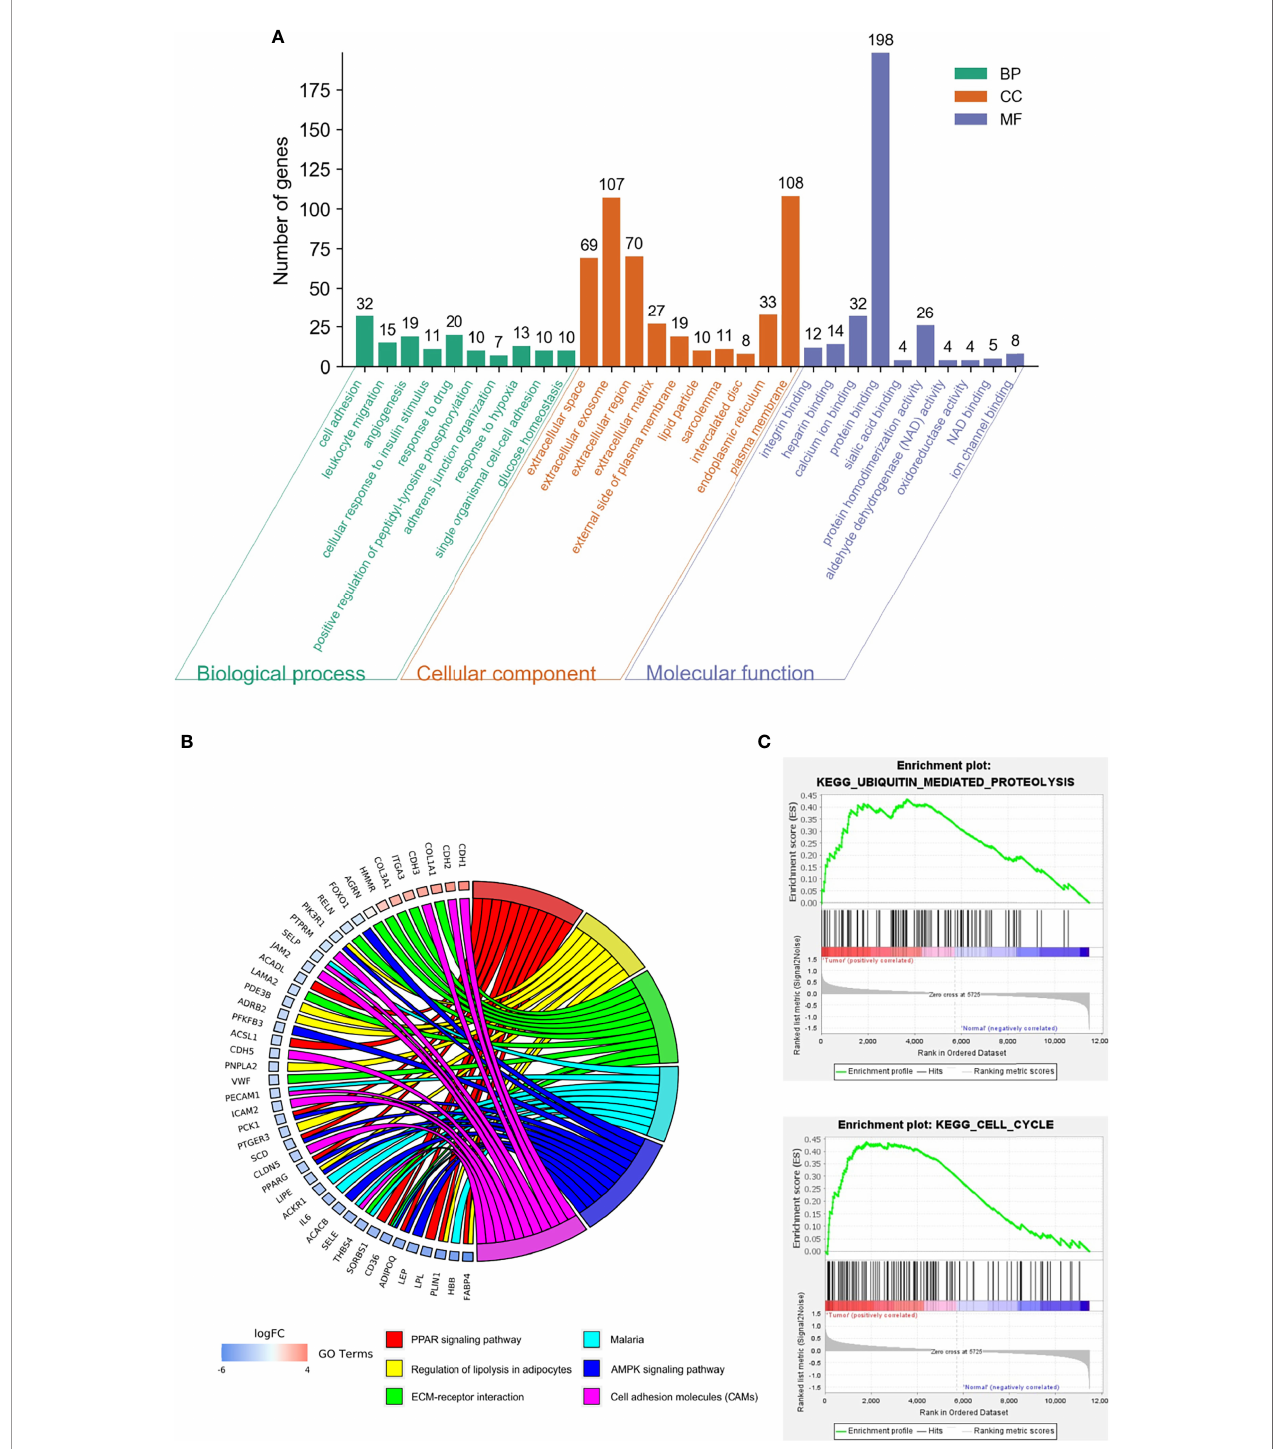
FIGURE 2 | Functional analysis of differentially expressed genes (DEGs). (A) Gene ontology (GO) function and Kyoto Encyclopedia of Genes and Genomes (KEGG) pathway enrichment analysis for DEGs were performed using DAVID Bioinformatics Resources. The enriched GO terms were divided into CC, BP, and MF ontologies. (B) Chord plot depicting the relationship between genes and GO terms of the top 100 DEGs. (C) Gene set enrichment analysis (GSEA) analysis of